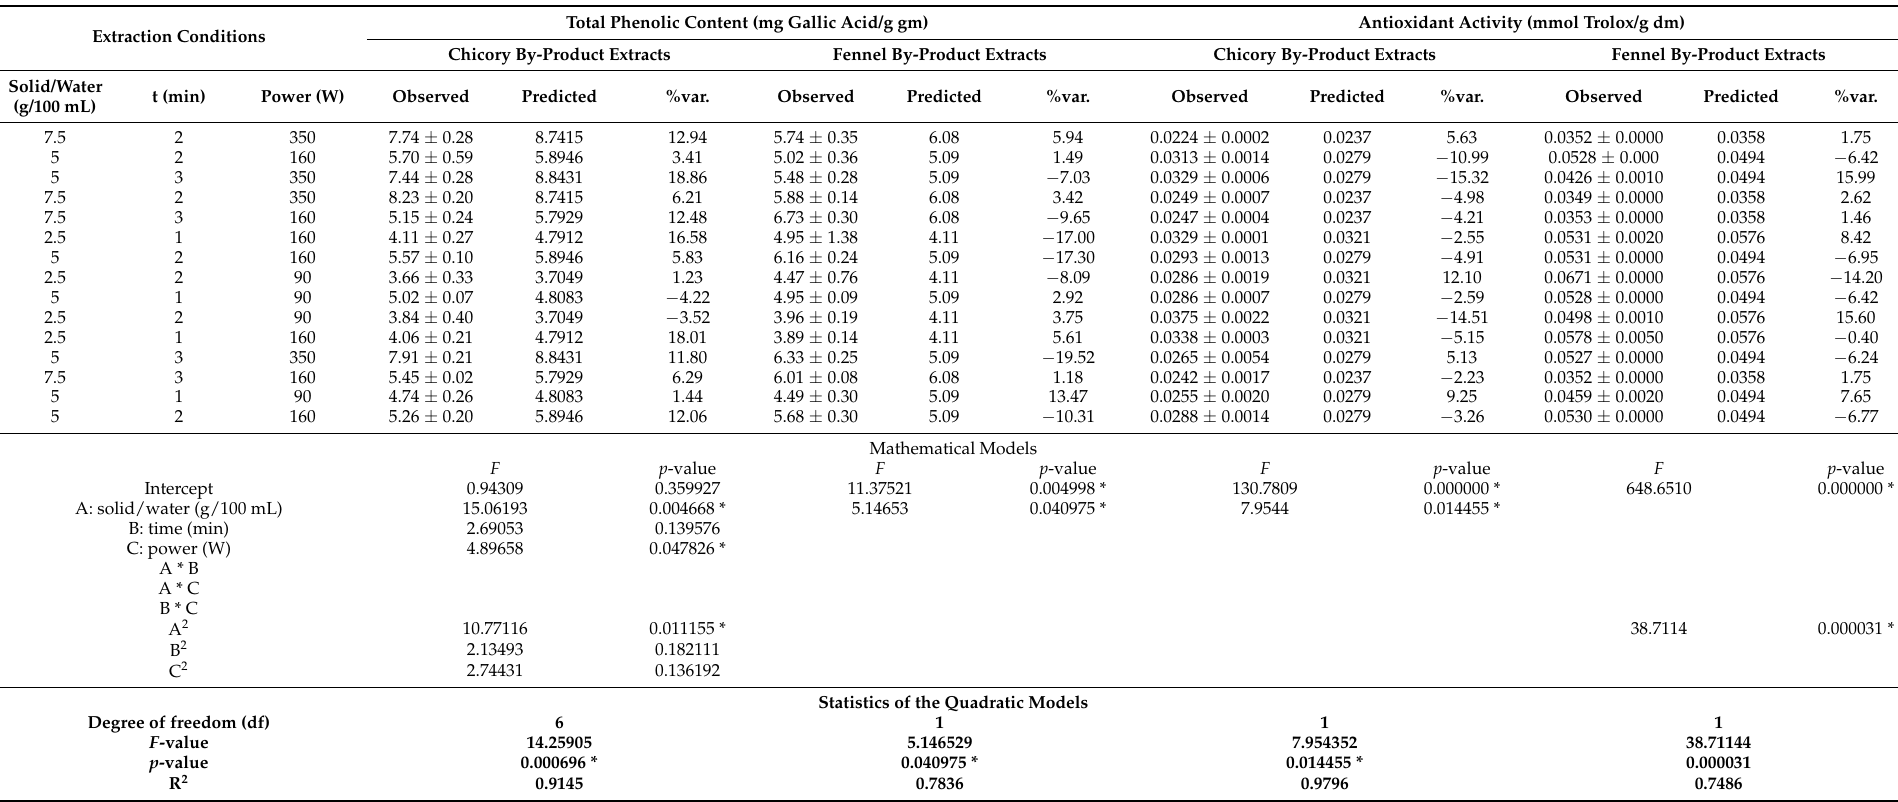
Table 3. Development of the Box–Behnken experimental design for microwave-assisted extraction: experimental results (observed) and values predicted by the models for total phenolic content and antioxidant activity; analyses of variance for linear, quadratic, and interactive effects of the independent variables and the determination coefficients of the